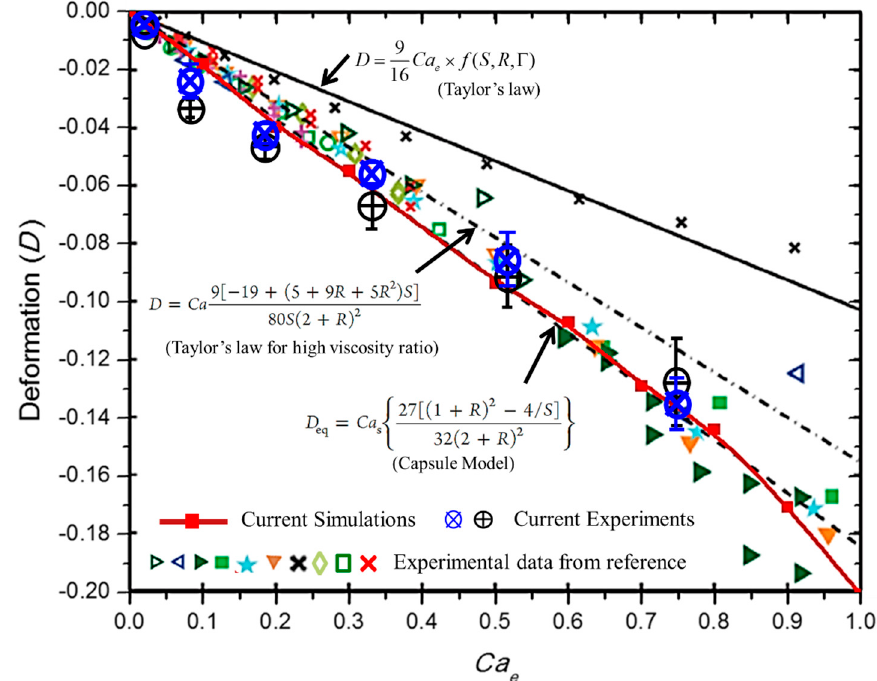
Figure 8. Simulation and experimental results pertain to the deformation of a particle-covered droplet under an electric field. For the experiments, we used two different asphaltene particle suspensions in silicone oil produced from asphaltene particles synthesized from two different feed stocks. The suspensions were dispensed in castor oil and the deformation of the particle-covered droplet was measured. The red line with filled rectangular symbols is obtained from our simulation model. The results are also compared against the experimental findings of Ouriemi et al. [33] for various types of particles, indicated by the different symbols and the capsule model (Equation (14)). The black solid, dot dashed, and dashed lines represent the theoretical models.